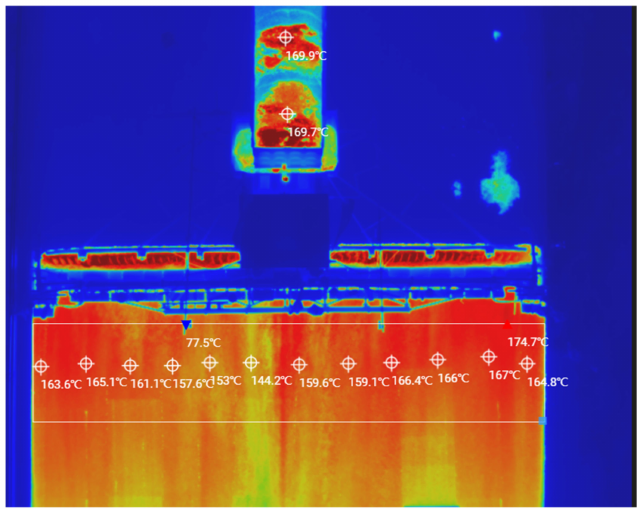
Figure 9. Infrared thermal image of asphalt pavement top layer